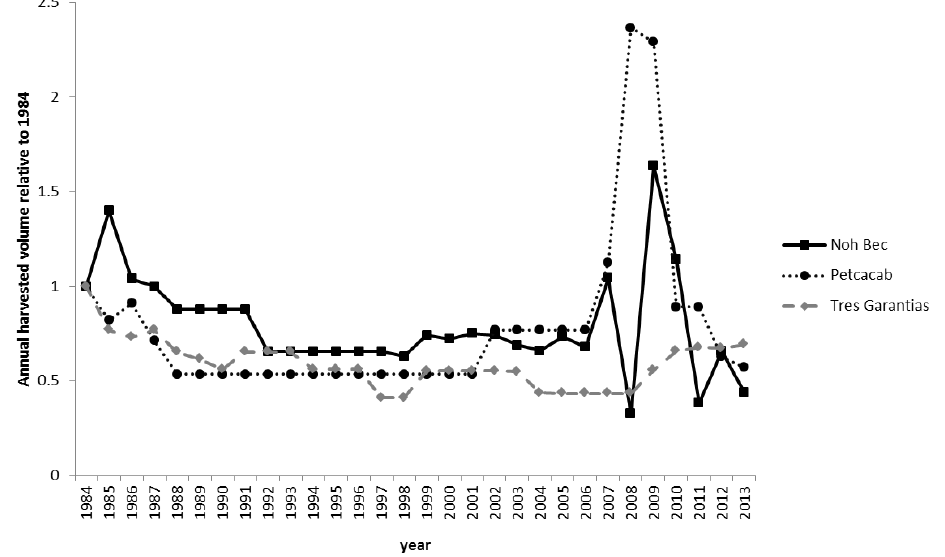
Figure 4. Annual precious timber harvests relative to 1984 volumes for the three communities with the largest timber production in Quintana Roo, Mexico (1984 to 2013). Precious timber includes big-leaf mahogany Swietenia macrophylla and Spanish cedar Cedrela odorata